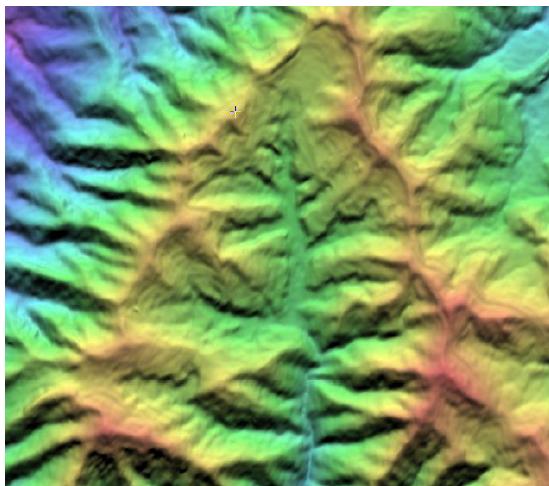
Figure 3. A sample from a merged DSM